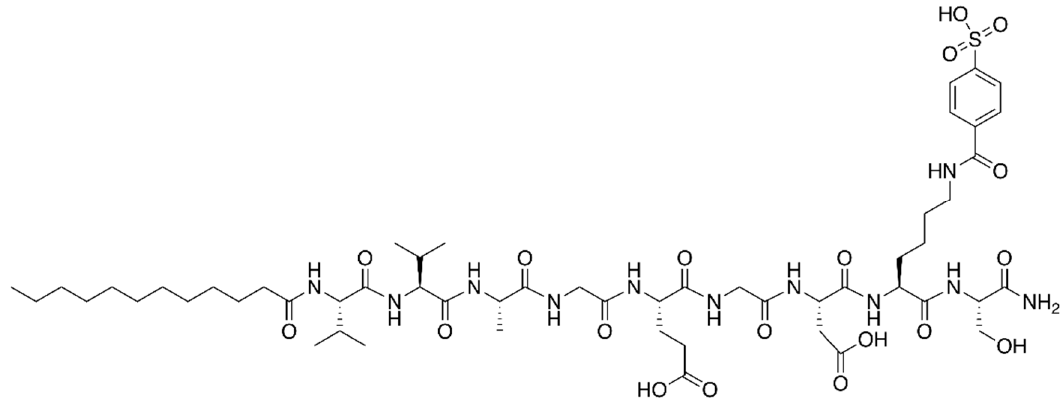
Figure 4. Structure of the heparin-mimetic peptide amphiphile developed by Mammadov and co- workers